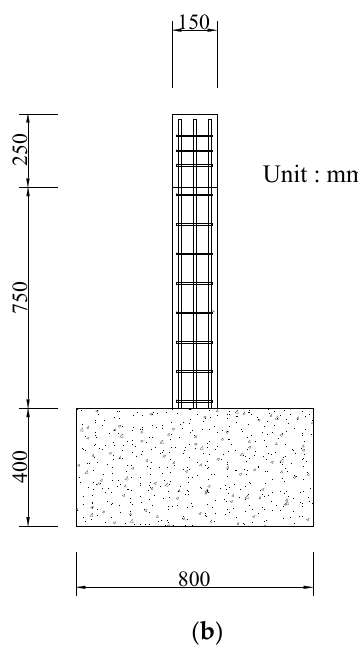
Figure 1. Details of Specimen FC (unit: mm): ( a ) front view; ( b ) side view.